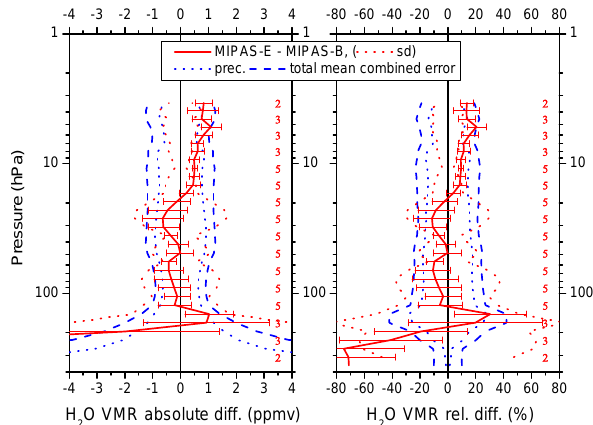
Fig. 2. Mean absolute and relative differences of all comparisons between MIPAS-E and MIPAS-B (red solid lines) including standard deviation (red dotted lines) and the standard error of the mean, plotted as error bars around the mean deviation together with precision (blue dotted lines) and total (blue dashed lines) mean combined errors. Red values (along the right-hand y-axes) indicate the number of collocations used for the statistical analysis at corresponding pressure levels.